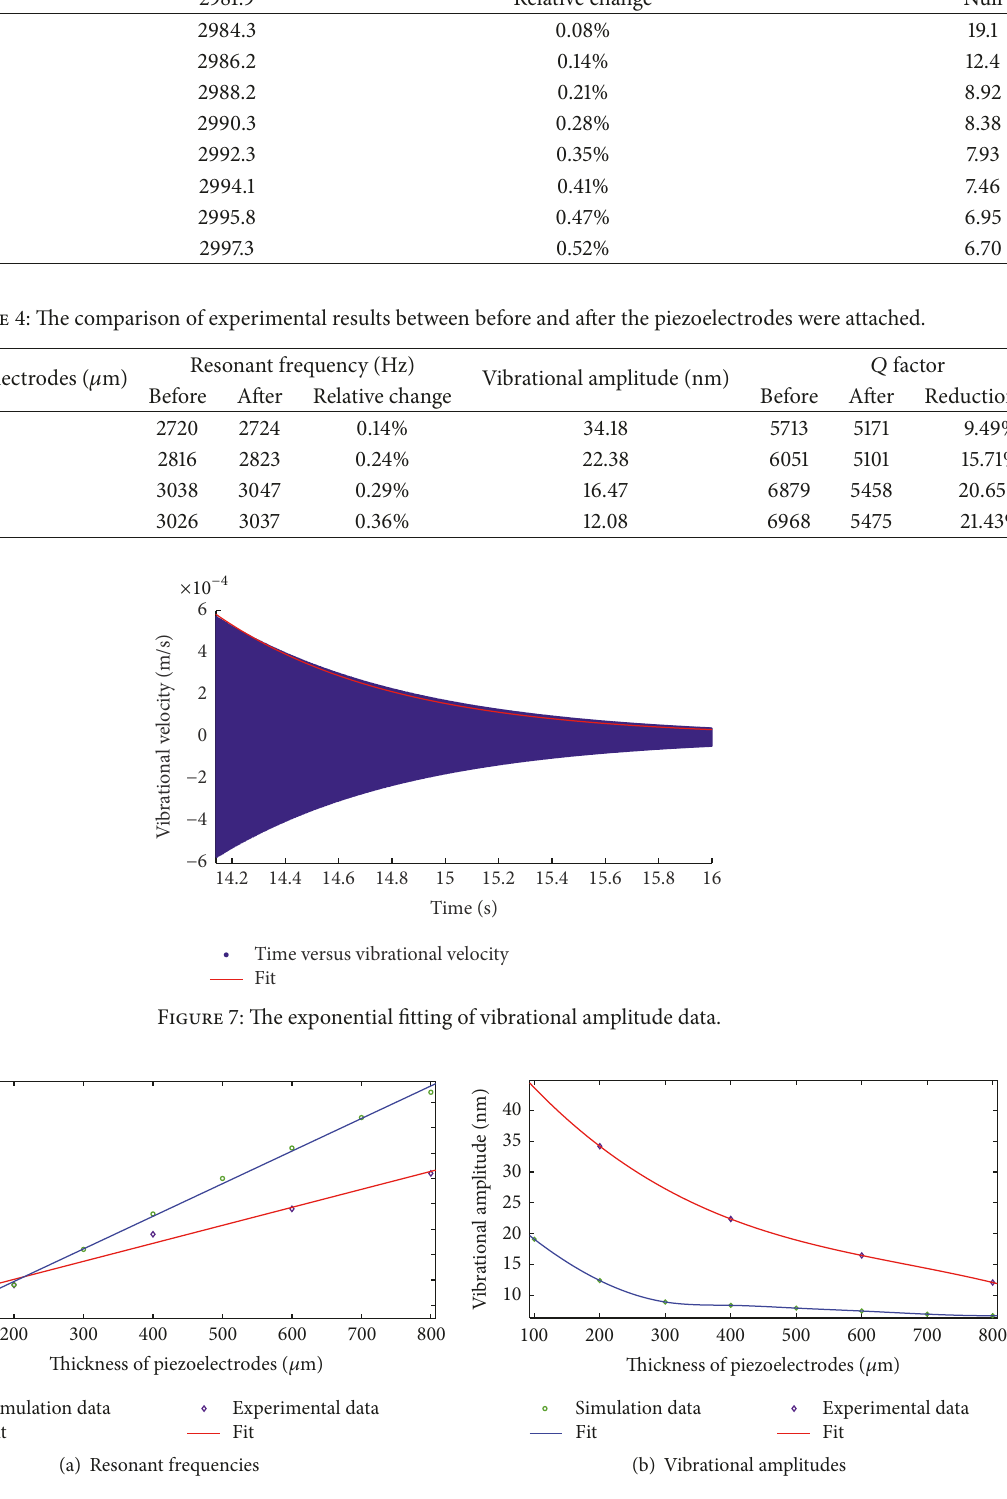
Figure 8: Comparison of the relative change of resonant frequencies and vibrational amplitudes under different thickness of piezoelectrodes between experiments and